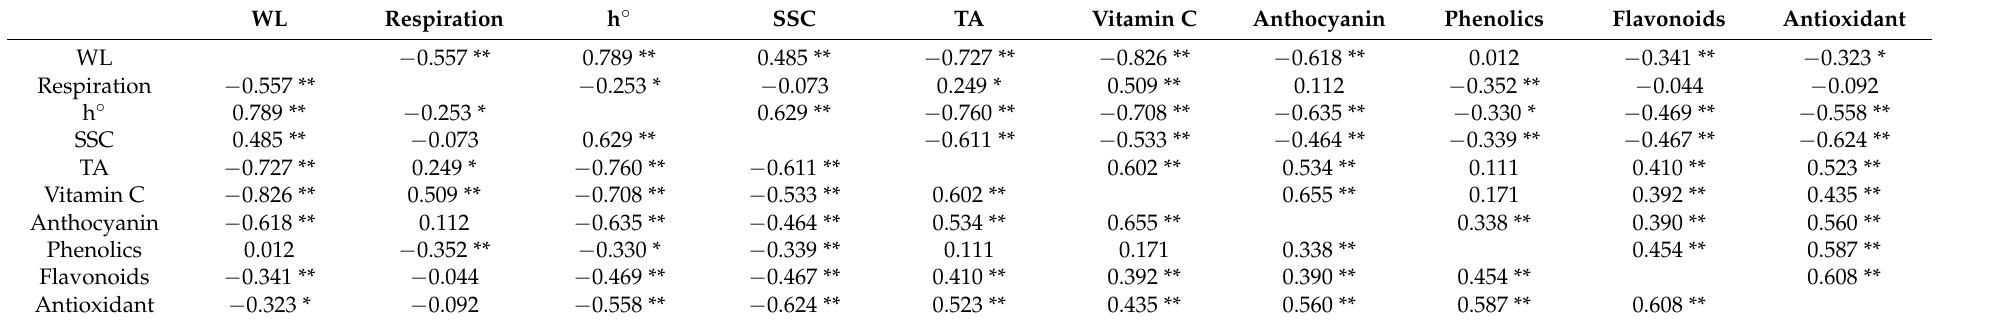
Table 1. Pearson’s correlation analysis between tested parameters of pomegranate